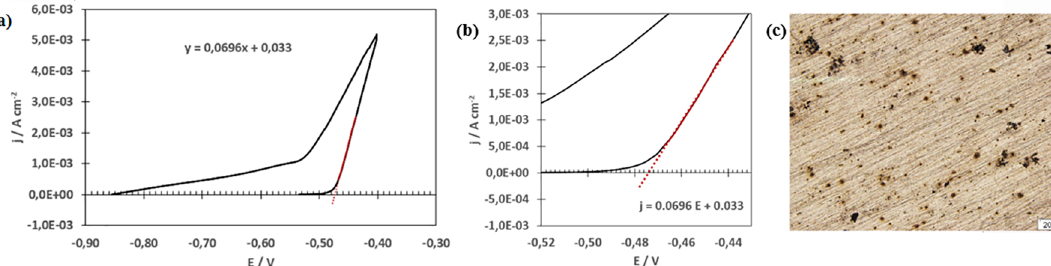
Figure 2. (a) Open circuit potential curve of the AA2524-T3 aluminium alloy in aerated 0.05 mol L -1 NaCl aqueous solution and (b) image of AA2524-T3 aluminium alloy by optical microscopy of surface after the open circuit potential test.